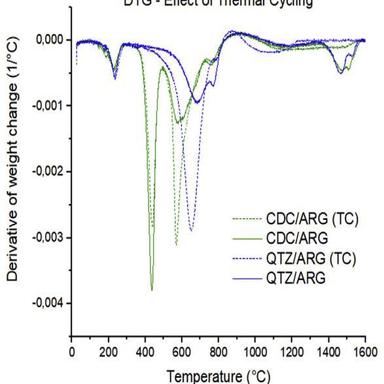
Derivative of the weight loss curves before and after thermal cycling (TC).